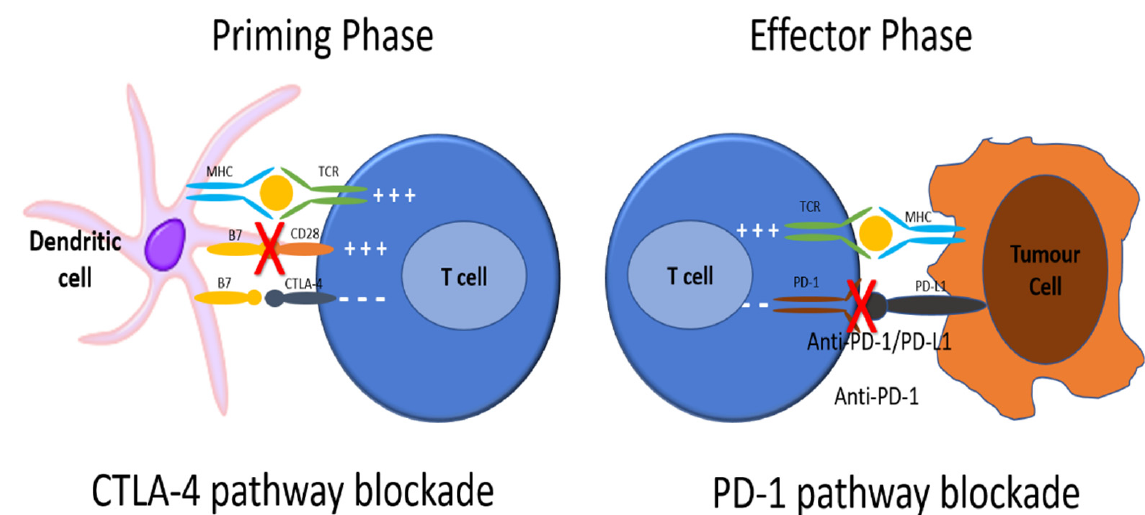
Figure 1. To be activated, T cells require major histocompatibility complex (MHC) class II molecules on an antigen presenting cell (APC) to present an antigen (Ag) that is recognized by the T cell receptor. Next, the CD28 receptor on the T cell is bound by CD80/86 on the APC, signaling the T cell to be activated. CTLA4 is found on T cell surfaces and competes with CD28 for binding to CD80/86 on the APC. When this interaction predominates, T cell activation signaling is attenuated. As well, PD-1 receptors are expressed on the surface of T cells. When PD-1 receptors are engaged by programmed death ligand 1 (PD-L1) on an APC, the T cell that recognizes the Ag being presented by the APC activates signaling pathways that downregulate activation and promote apoptosis. There is also reduced apoptosis of T-regulatory cells (Treg), facilitating downregulation of the immune response to that antigen. Cancer cells exploit these important physiologic mechanisms by upregulating PD-L1 expression on their cell surface, thereby attenuating any anti-tumor immune response through inducing the quiescence of tumor-reactive T cells. ICIs such as anti-CTLA-4, anti-PD-1, and anti-PD-L1 antibodies have been developed to restore the immune system’s ability to mount an anti-tumor immune response. Anti-CTLA-4 antibodies block the interaction between CTLA-4 and CD80/86 on the APCs, allowing for increased T cell activation. Anti-PD-1 and anti-PD-L1 antibodies block the interaction between PD-1 and PD-L1, allowing for increased T cell activation to Ag being presented by the tumor cell. In this way, the tumor cell is no longer recognized as “self”, tumor-reactive T cells are no longer shunted towards quiescence, and an anti-tumor immune response can be